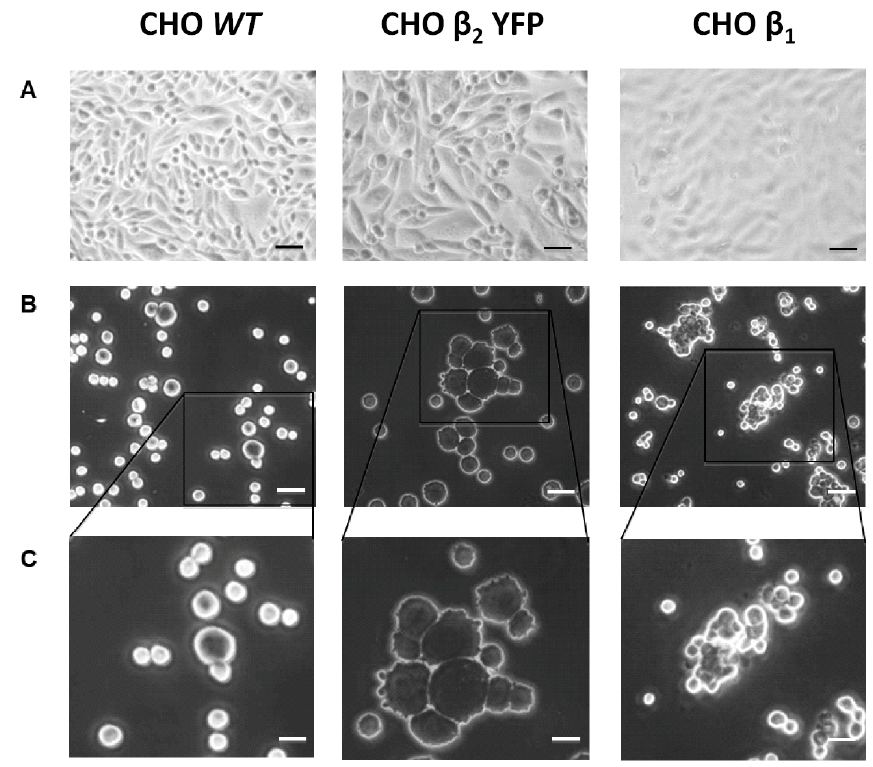
Figure 3. CHO cells expressing the β 2 YFP subunit are highly adhesive. ( A ) A representative bright field image is shown for the indicated CHO fibroblast taken before Dispase I treatment. ( B ) Following 40 min of incubation with dispase I, the cells were subjected to mechanical force by pipetting and the dissociated particles were dropped on slides (30 µ L) and imaged in bright field with 20 × objective. ( C ) Larger image of cell particles of each cell line is shown from the inset in panel B (bar scale in A and B is 30 µ m, in C 10 µ m).